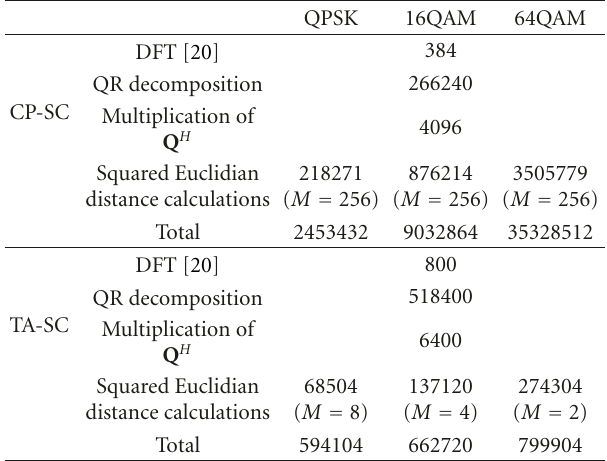
Table 2: Number of multiplications (uncoded with N c = 64 and L =